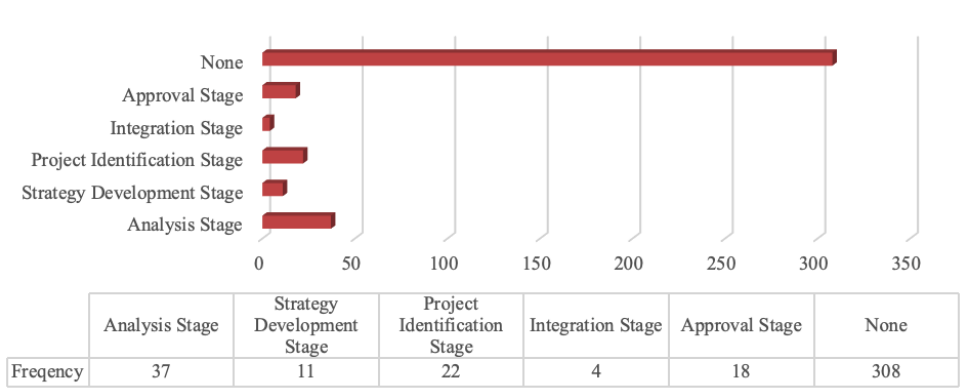
Figure 4: Participation stage(s); Source : Authors